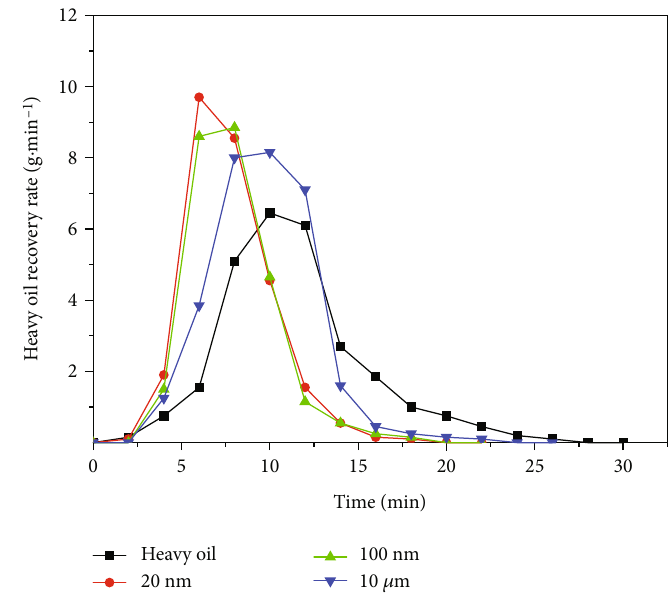
Figure 13: The experimental heavy oil recovery rate curves of each group under di ff erent water